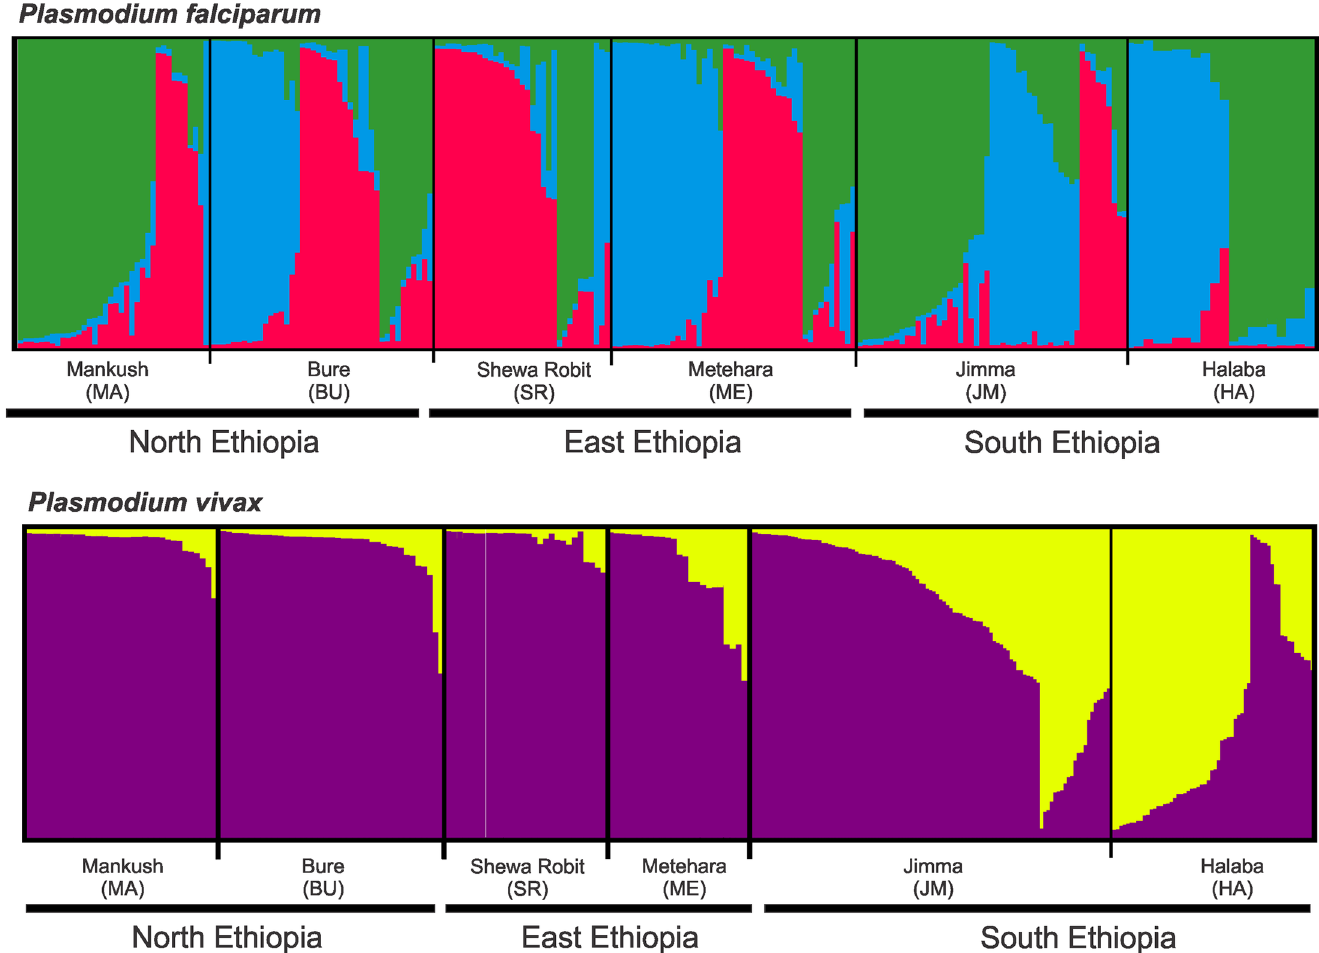
Fig 2. Bayesianinferences of the K clusters estimated by STRUCTURE among Plasmodium falciparum and P . vivax samples. The most probable clusters are labeledby different colors, and individualsare represented as columns.Within each column (individual), the extent of the componentcolors indicatesthe magnitude of the membershipcoefficient (Q) corresponding to each cluster. Q values of respectiveclusters are presented in S5 Table.